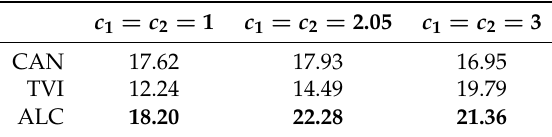
Table 1. Minima of the maxima Mahalanobis distances achieved with Canonical PSO (CAN),